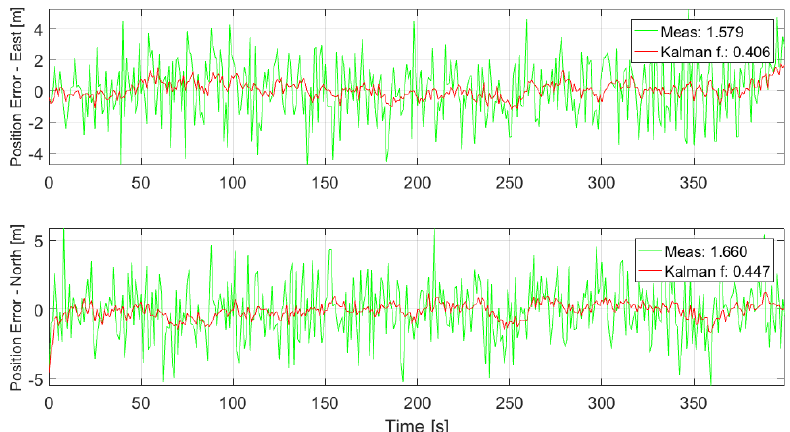
Fig. 5. GNSS errors along the east and north